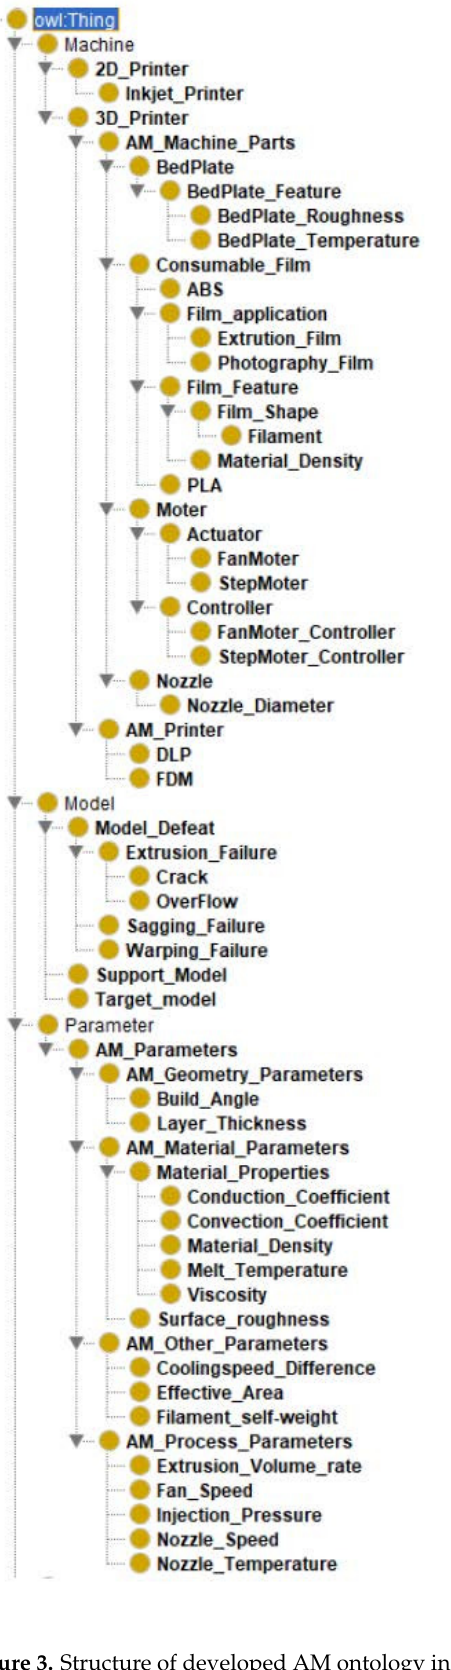
Figure 3. Structure of developed AM ontology in Protégé software (version 5.5.0) .